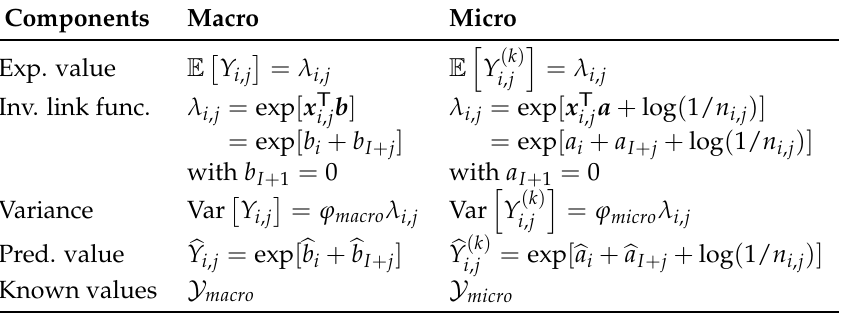
Table 1. Quasi-Poisson macro- and micro-level models for reserve ( i , j = 1, . . . , I ). All clusters and all payments are